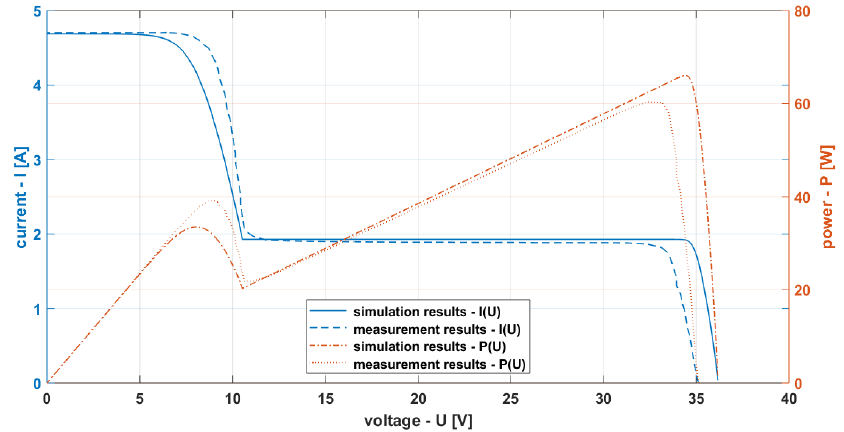
Figure 7. I–V characteristics of PV module STP255-20/Wd made with partial shading. For detailed comparison of measurement and simulation results, see Table 2. Marking of measurement point P2 (four PV cells were shaded; the exact measurement time was 10:36 a.m.).